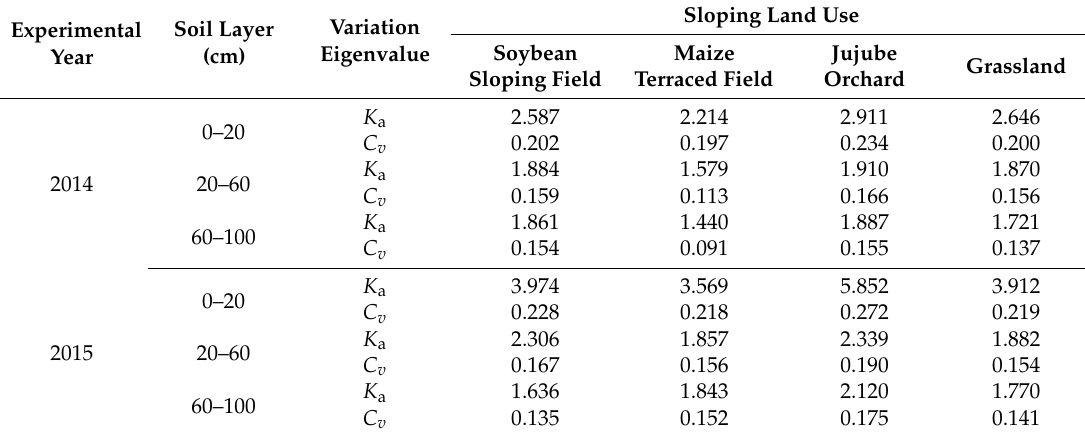
Table 4. Statistical analysis of soil temperature changes in profile under di ff erent sloping land uses.